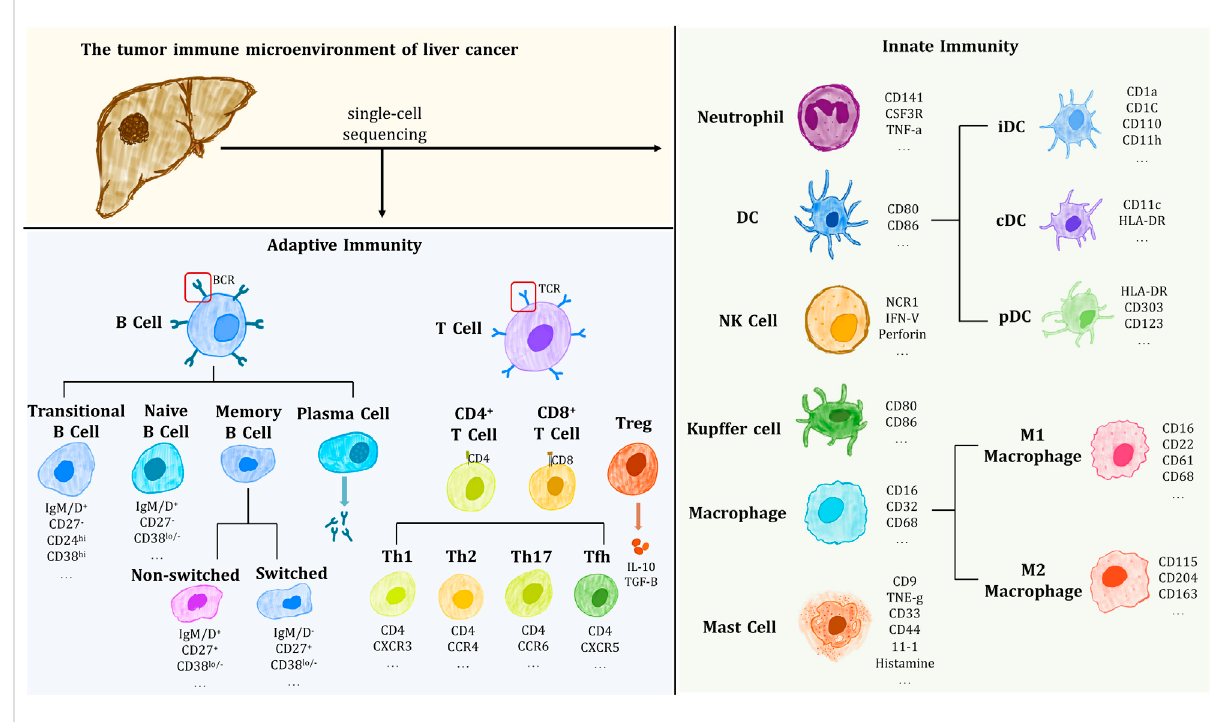
FIGURE 1 Immune cells and their markers isolated and identi fi ed in the immune microenvironment of HCC